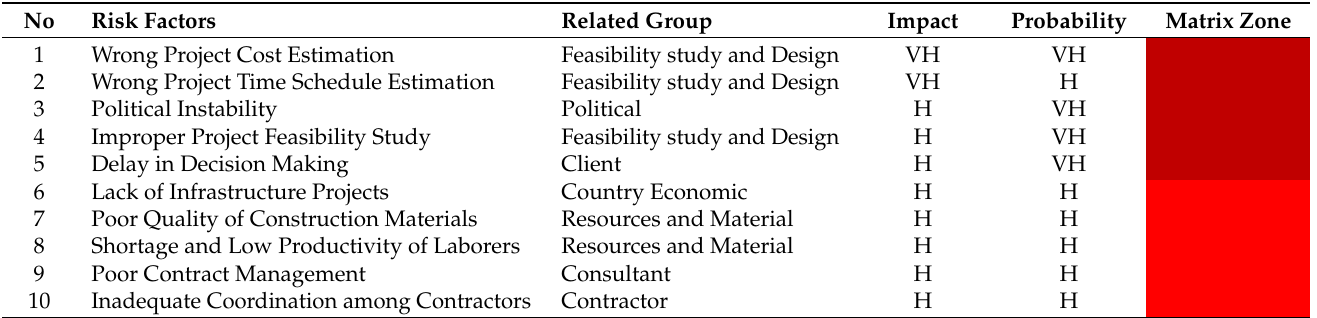
Table 7 ranks the risk variables based on their relative relevance index, combining their